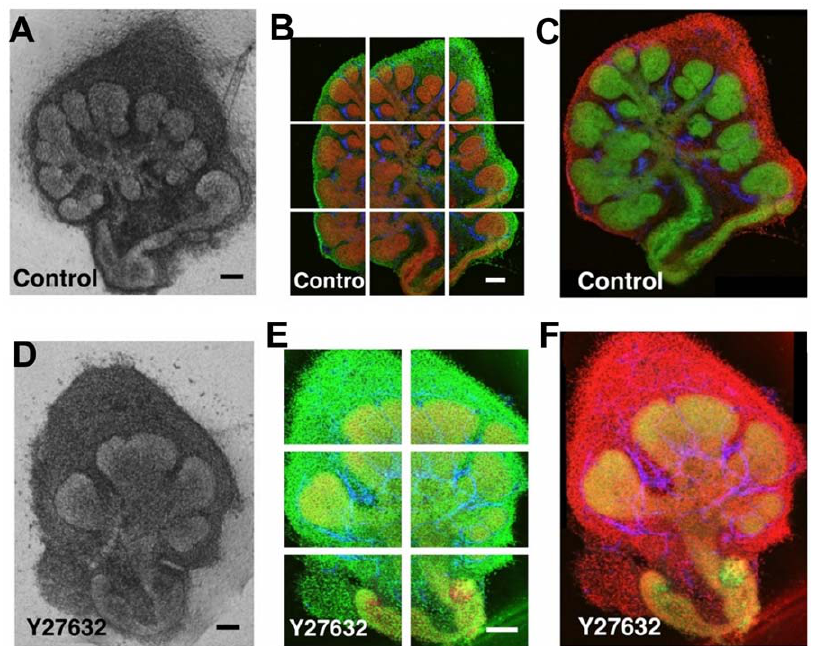
Figure 1. Acquisition and image processing of confocal images. Organotypic culture of E13 SMGs (a) control or (b) treated with ROCK inhibitor (140 m M Y27632), showing reduced branching with ROCK inhibitor treatment. Explants were immunostained with anti-E-cadherin antibody as an epithelial marker (red) and SYBR green as a total nuclei marker (green). Multiple overlapping confocal images through the mid-section of (c) control- and (d) ROCK inhibitor-treated explants were captured to cover the whole explant. Images were stitched using the inverse Fourier transform of the phase correlation matrix and blended to provide composite images of (e) control (f) and ROCK inhibitor treated explants. Scale bars: 200 m m (a, b), 100 m m (c), (d), and (e), and (f). In our study, the sublingual tissues were discarded and only the submandibilar gland was used, (Figure S2).